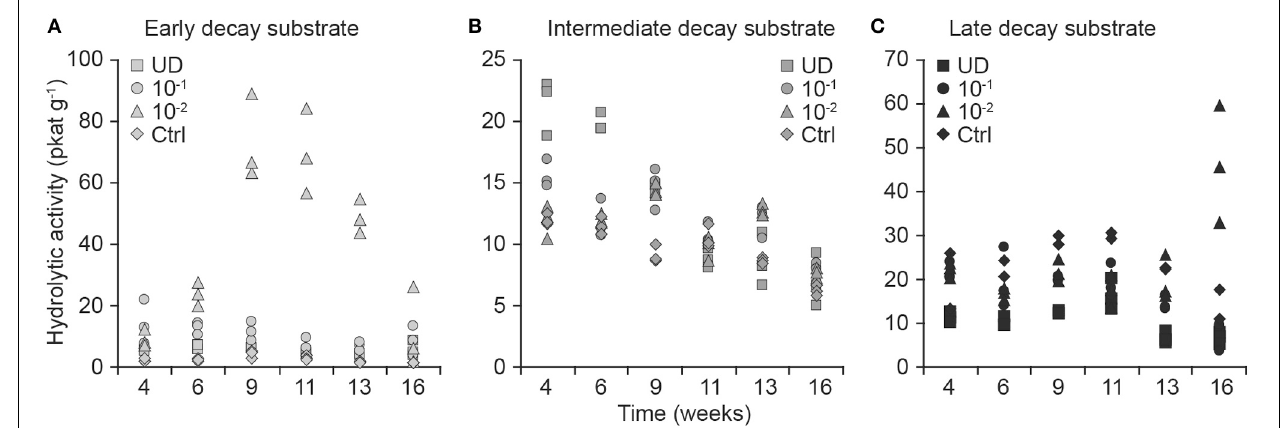
FIGURE 4 | Effect of fungal community dilution on total hydrolytic activity (pkat/g of substrate; in dm) as the sum of 1,4- β -glucuronidase, 1,4- β -xylosidase, cellobiohydrolase, and 1,4- β -glucosidase from early-decayed (A), intermediate-decayed (B),